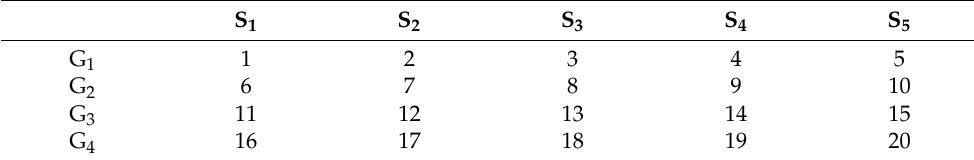
Table 3. Individual